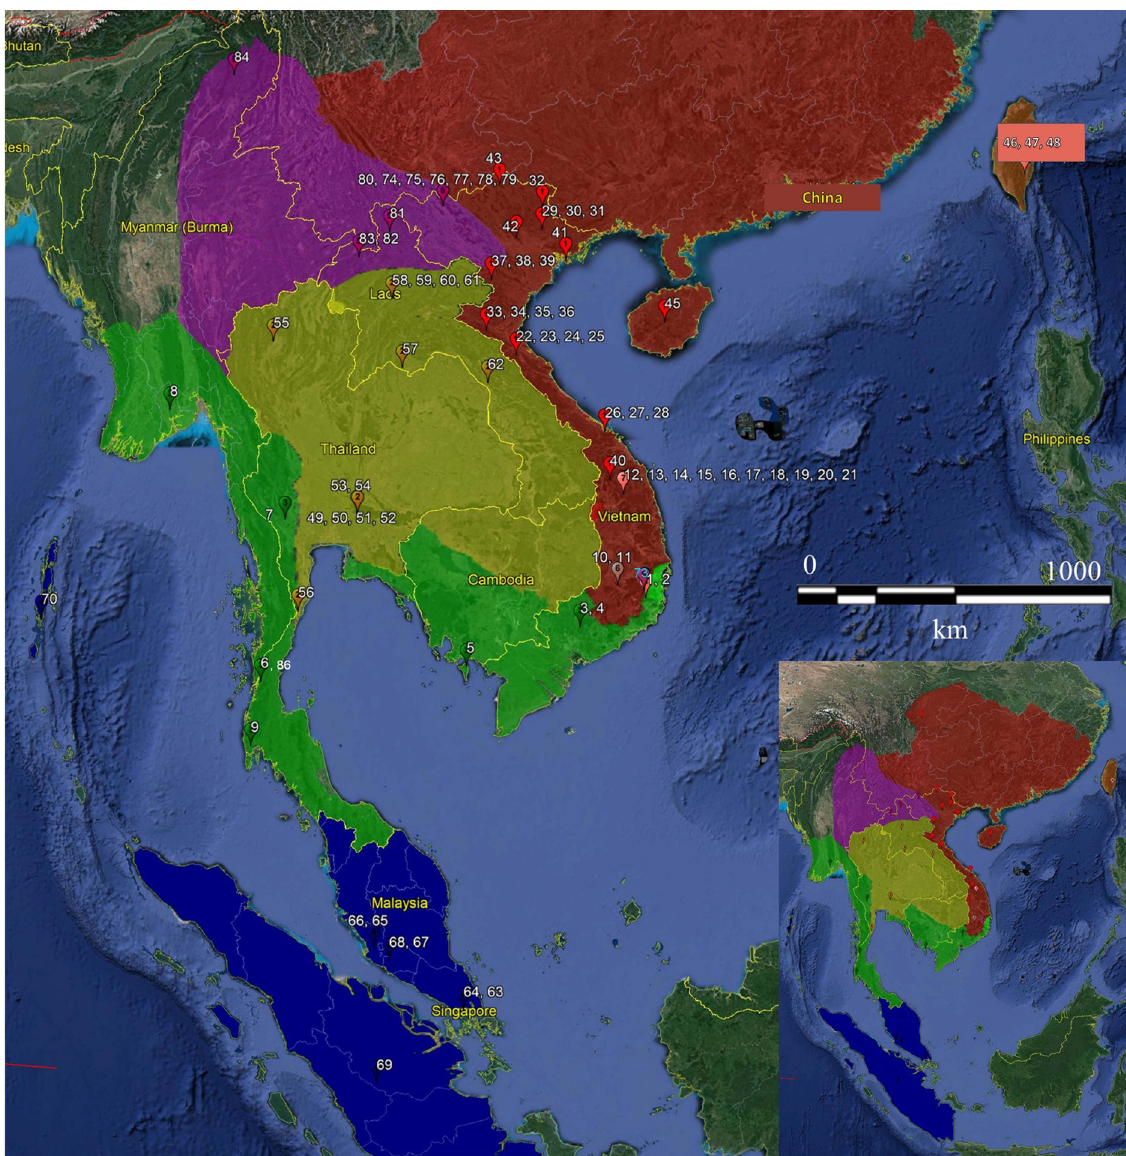
Fig. 5. Map showing the distribution pattern of the Microhyla heymonsi group based on available molecular and morphological data collected from East and Southeast Asia (red area: M. heymonsi s. str. Vogt, 1911 and M. cf. heymonsi ; yellow area: Microhyla sp1; blue area: Microhyla sp2; green area: M. ninhthuanensis Hoang et al ., 2021; pink area: Microhyla hmongorum